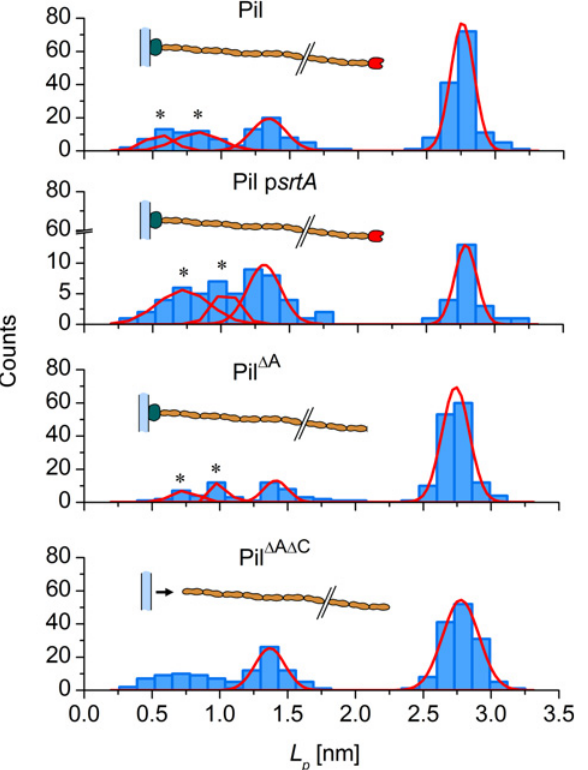
Fig 5. Histograms of persistence length L p (nm). The positions are provided by fitting WLC model to force spectroscopy data on the Pil strain and its pili-displaying derivatives with 1.5 μ M BSA or 15 μ M BSA for the Pil p srtA strain. Data were fitted using the Gaussian function (solid line) and Gaussian multi-peak analysis (solid line and black star ( * )).